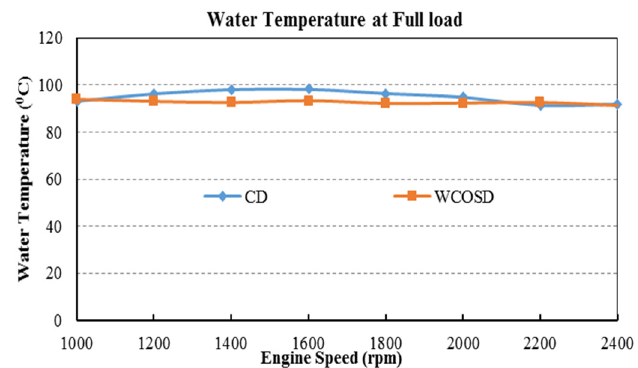
Figure 5. Cooling water temperature at the full load condition.